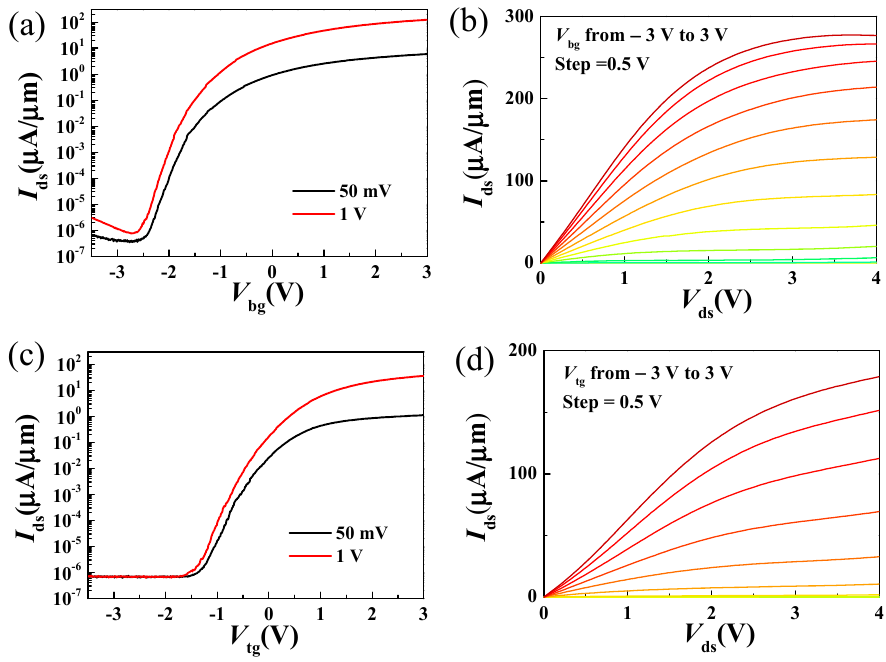
Figure 3. ( a , b ) Transfer and output characteristics of the MoS 2 dual-gate transistors from the back-gate controls. ( c , d ) Transfer and output characteristics of the MoS 2 dual-gate transistors from the top-gate controls.